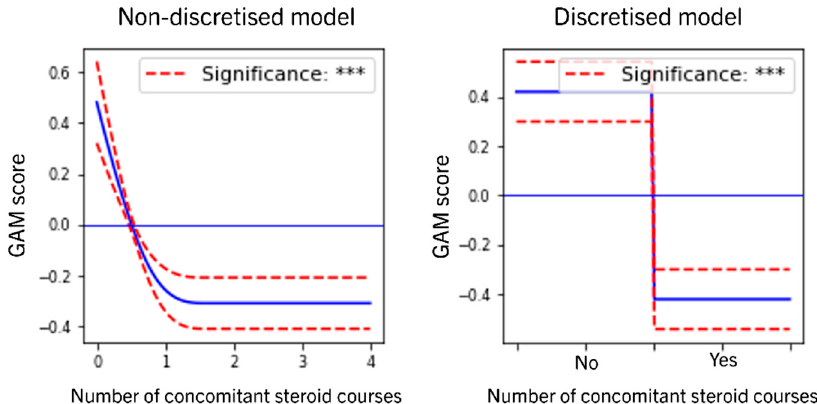
Figure 4. Visual summary of the effect of the number of concomitant steroid courses in the longitudinal remission model, non-discretized model ( left ) and discretized model ( right ). Horizontal blue line denotates 0 (no effect), solid blue line represents the estimated effect of different values of the covariates and discontinuous red lines represent 95% confidence intervals. *** p < 0.001.